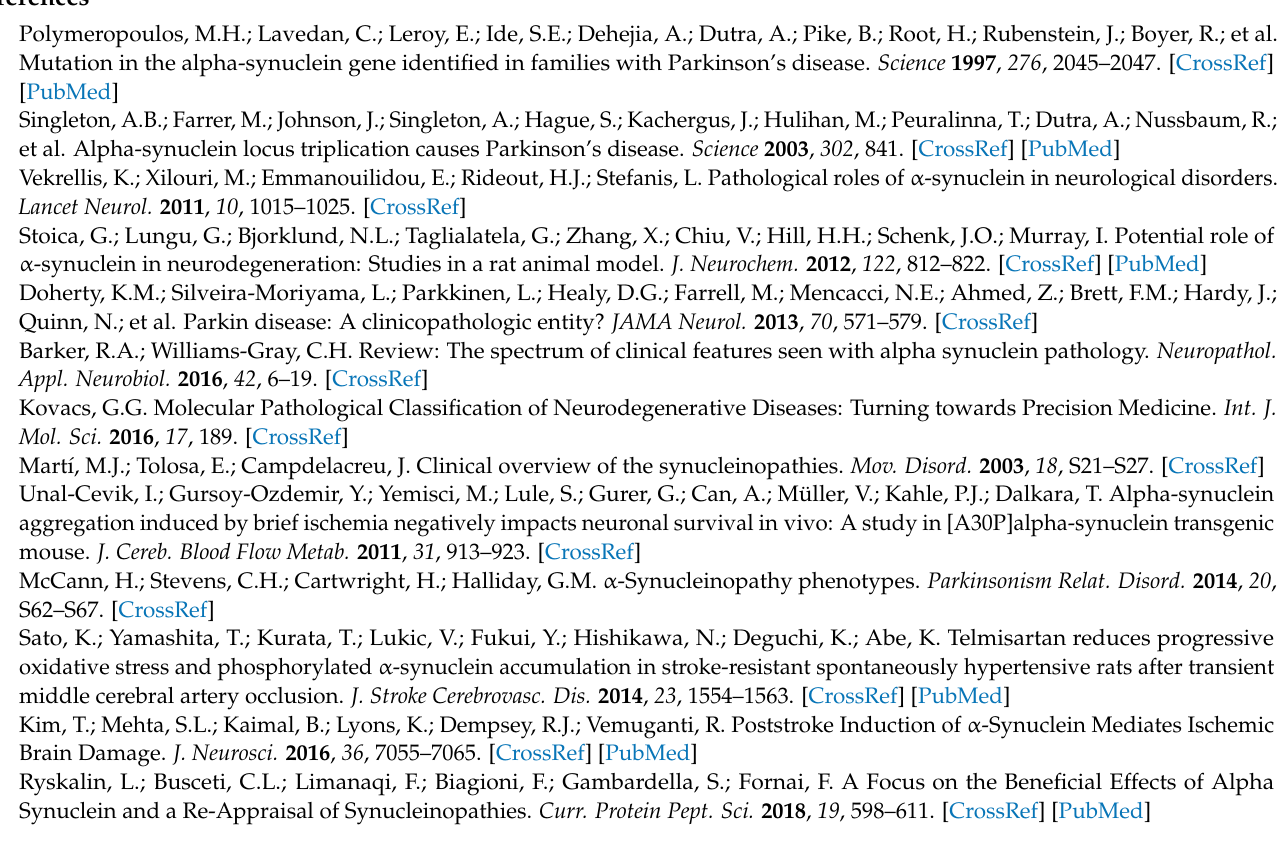
housekeeping protein α -actin shown in Figure 9, Figure S6: Alternative quantification of immuno- blotting for PK-resistant α -syn with respect to the monomeric α -syn from PK-untreated samples, Figure S7: Immuno-blotting for α -syn in U87MG cells transfected with α -syn siRNA. Figure S8: Silencing α -syn in U87MG cells does not induce